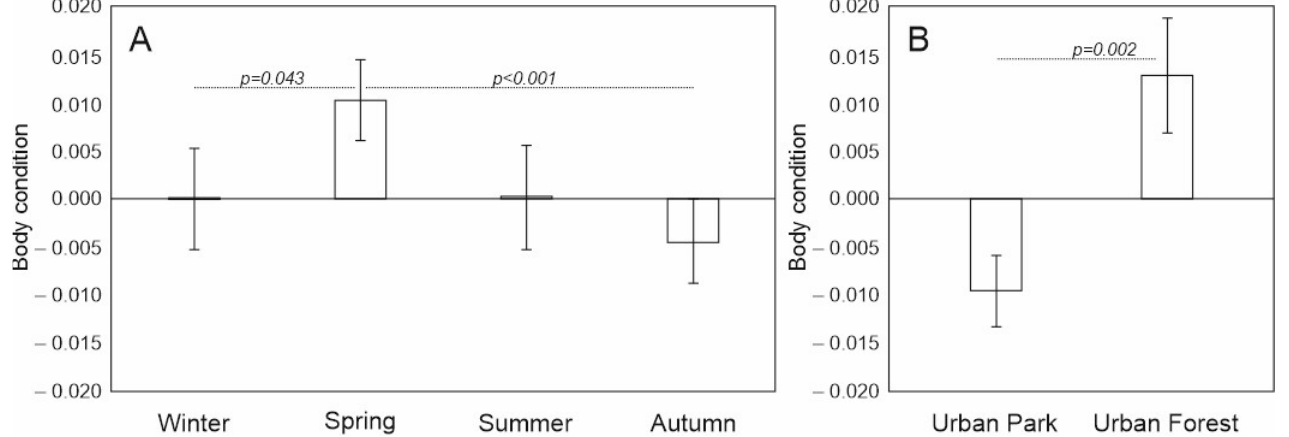
Figure 4. Mean (±SE) body mass of adult red squirrels with regard to ( A ) season and ( B ) study site, and pairwise comparison with Least Significant Difference test in LMM (significant differences presented above the bars). Please note that Y axis does not start from 0 value.